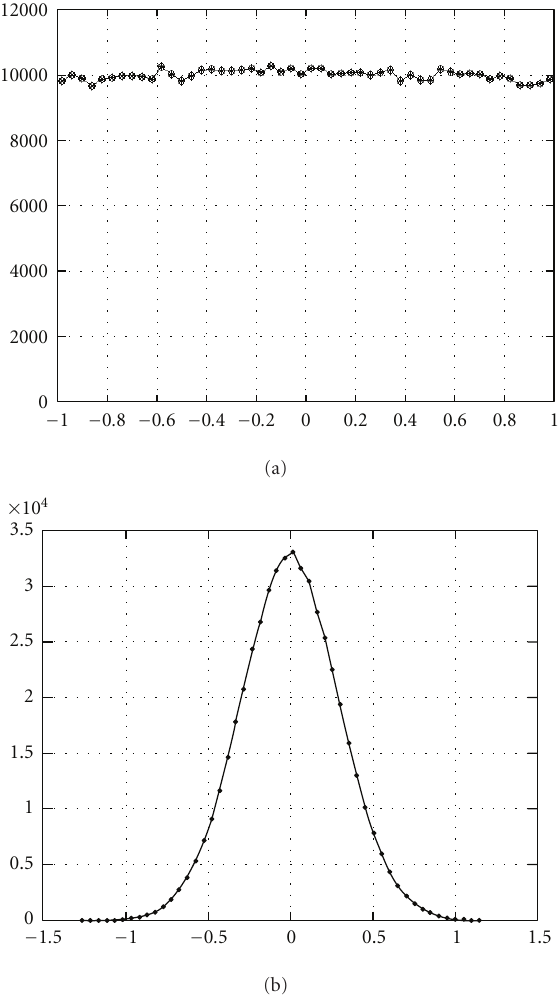
Figure 6: Transformation of a uniformly distributed input signal (a) into a Gaussian noise (b) using the LUT-based interpolator programmed with the nonuniform sampling scheme α of Tables 1 and